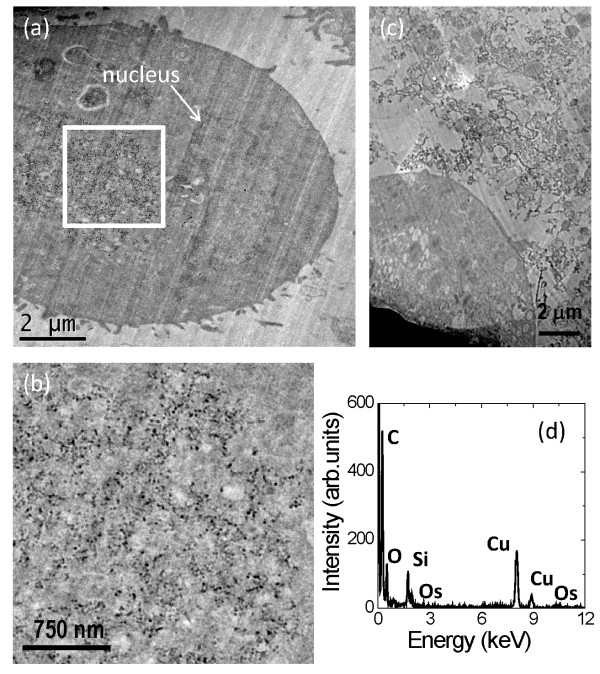
(a) TEM image of an A549 cell after incubation with 10 μg/ml silica NPs for 24 hrs at 37°C. (b) Higher magnification image of the area indicated by the box in (a). (c) TEM image of A549 cells after incubation with 100 μg/ml silica NPs for 24 hrs at 37°C, showing a corner of one of the few remaining cells and surrounding it a large amount of cell debris, which was predominant throughout the sections. (d) EDX spectrum from the silica NP containing region of the A549 cell shown in (b).